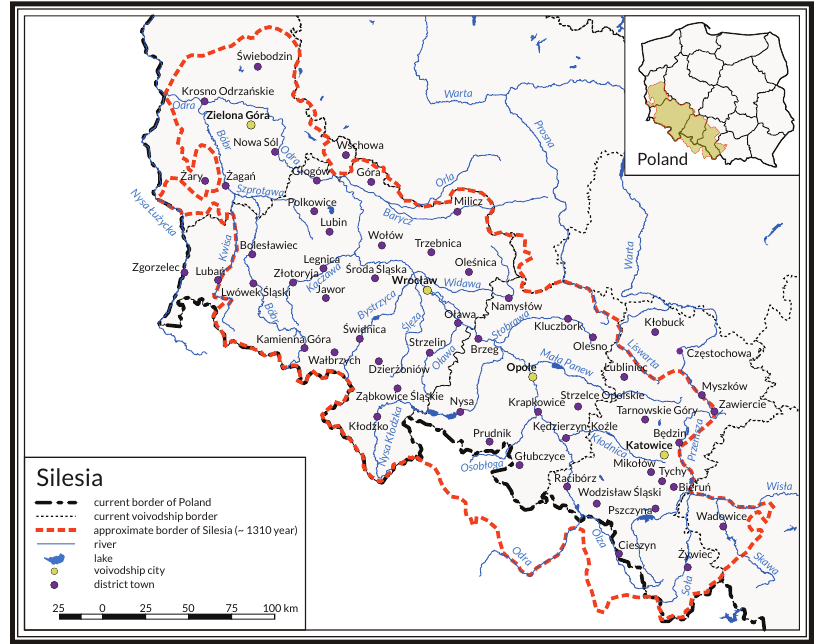
Figure 3. The area of Silesia considered in the first volume of SENG´S (in EPSG:2180). Editorial rules were verified in the second volume, and the territorial range was reduced to the areas within Polish borders, mainly due to the publication of the Místní jména na Moravˇe a ve Slezsku (“Local names in Moravia and Silesia”) dictionary [12].